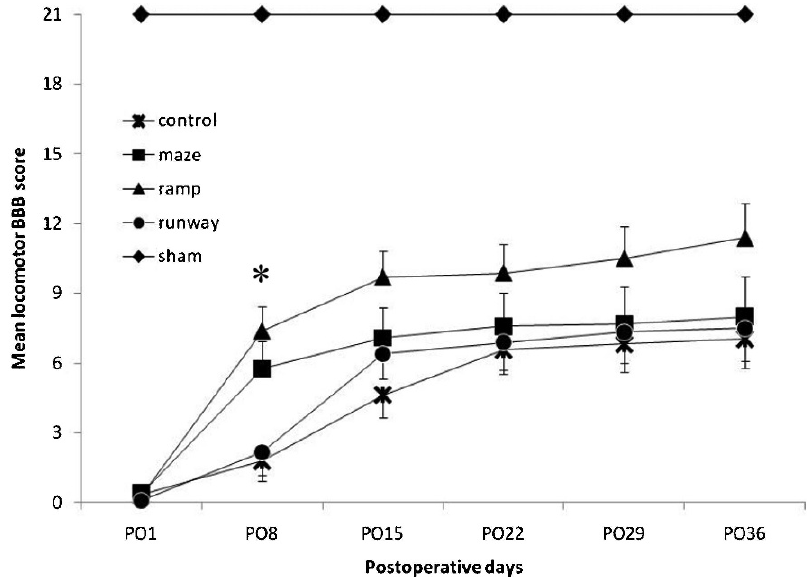
Figure 3 - The time course of locomotor recovery as measured by BBB open field scores for ramp, maze, runway control and sham groups. Since the 1 st POd the sham group punctuated 21, showing no motor deficits. Maze and ramp groups showed greatest recovery when compared to runway and control groups on the 8 th POd (* p = 0.001), but this difference did not persist till the 36 th POd, although the ramp group tended to have a better performance.